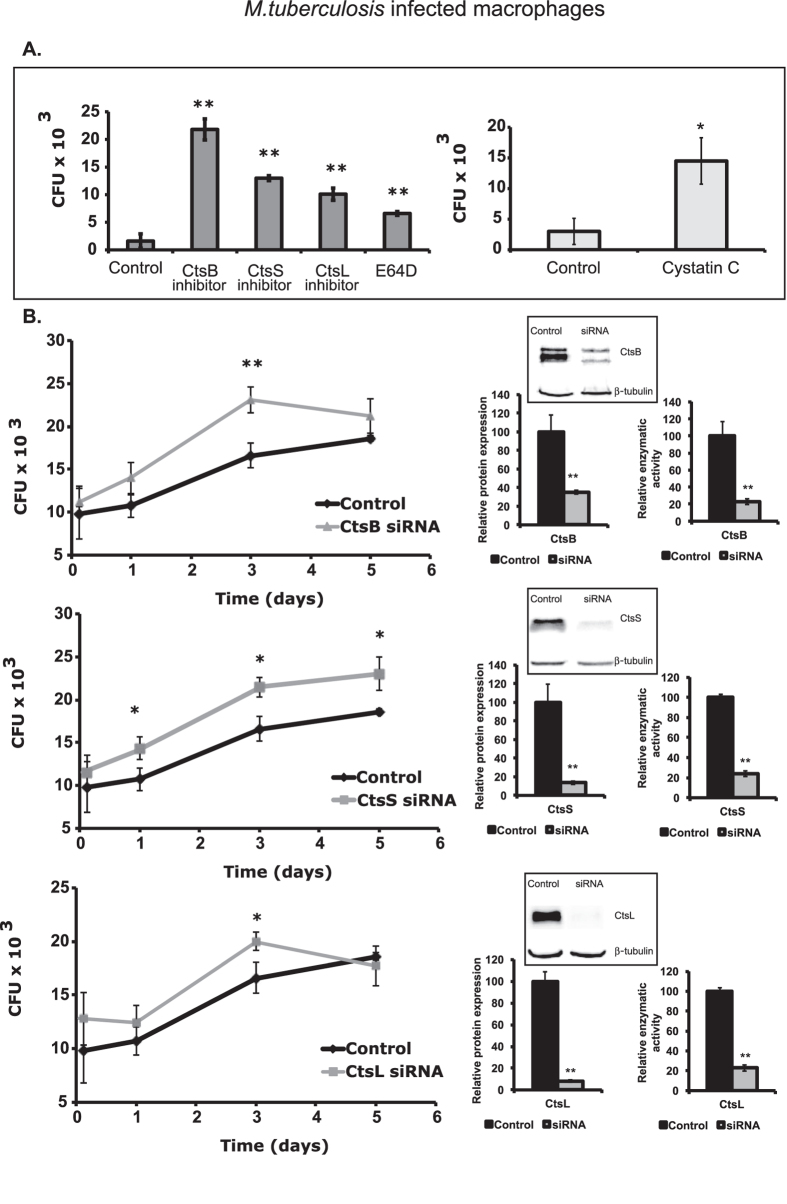
Effect of cathepsin B, S and L inhibition on MTB survival.(A) Cathepsin activity was inhibited using 20 μM of specific inhibitors or cystatin C 24 h prior to infection or 10 μM of the general cysteine cathepsin inhibitor E-64d after infection in M1 macrophages. Values are depicted relative to untreated control (*p < 0.5; **p < 0.01 relative to untreated control). (B) Effect of cathepsin B, S and L silencing on MTB survival in resting (M0) macrophages. Each cathepsin was silenced by siRNA 3 days prior to infection in order to achieve maximum protein silencing and reduction of enzymatic activity (on the right). Controls were transfected with a scramble siRNA (*p < 0.05; **p < 0.01 relative to control; n = 3).